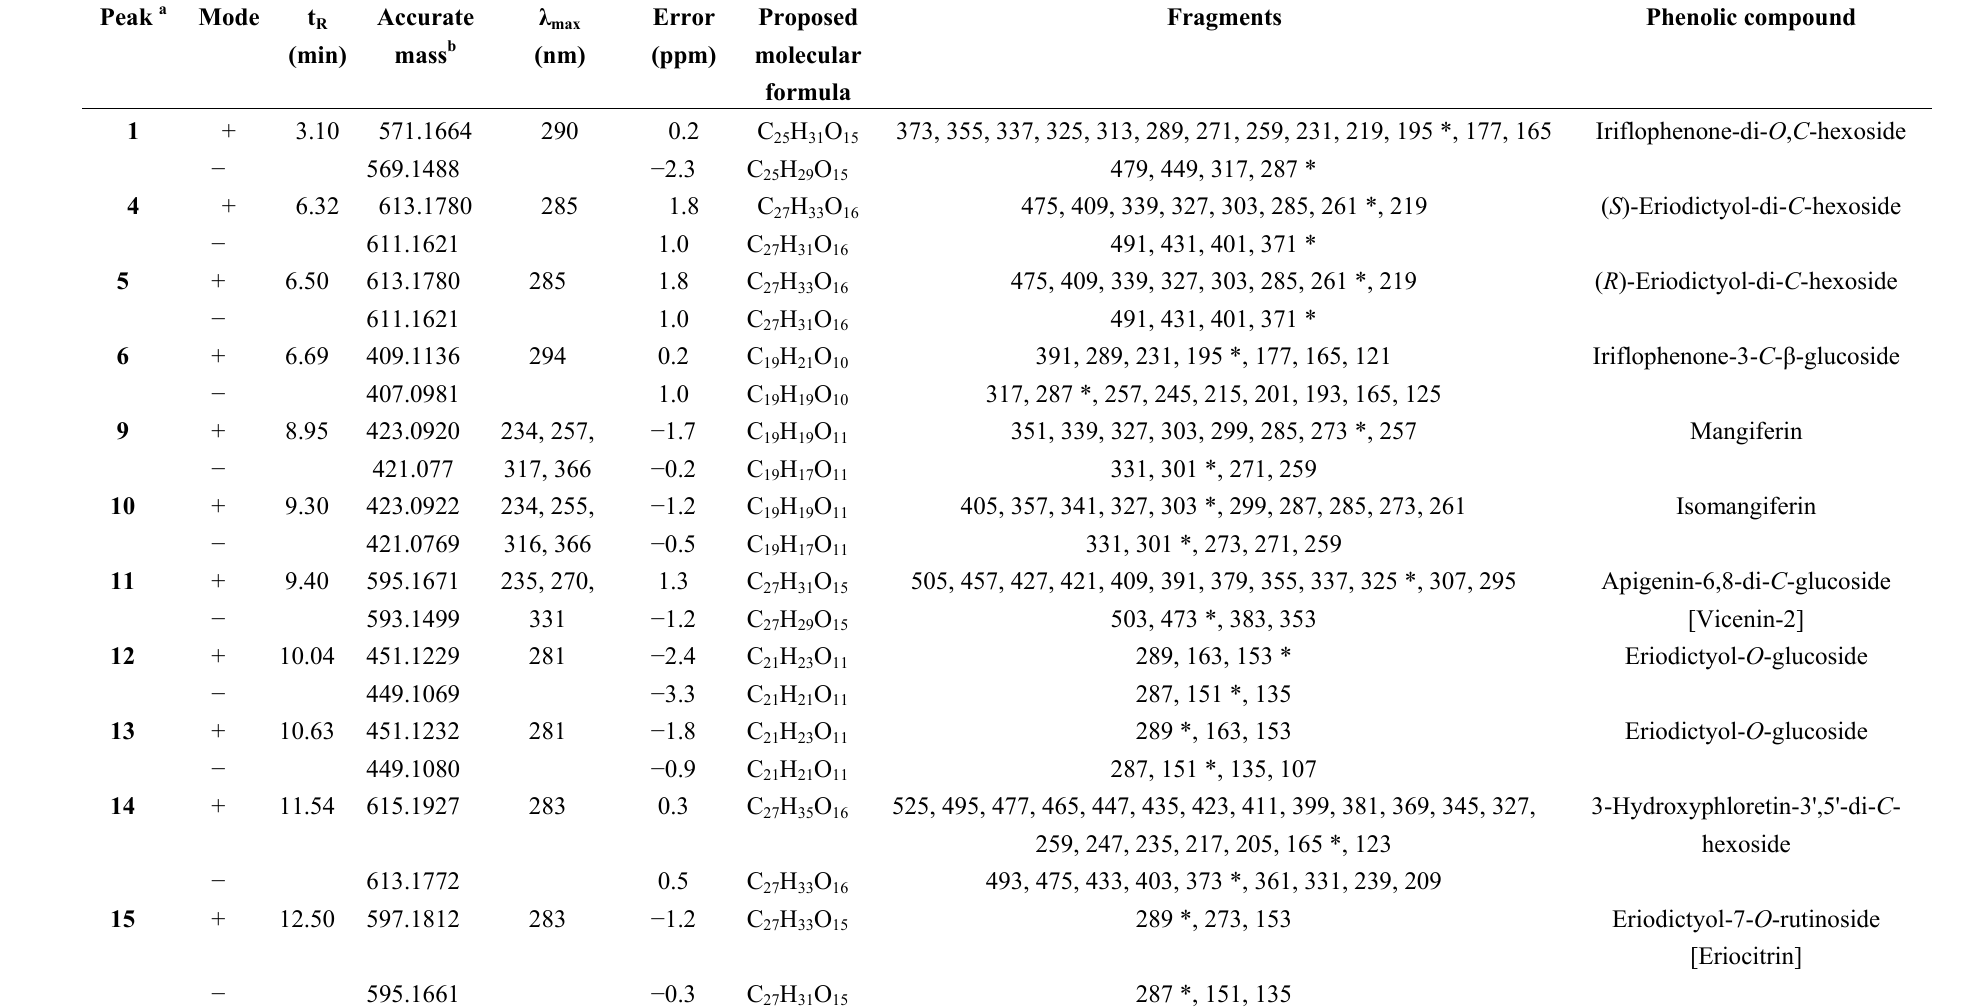
Table 1. UV-Vis, LC-MS and LC-MS/MS characteristics of phenolic compounds identified in freeze-dried aqueous extracts of green and fermented Cyclopia subternata